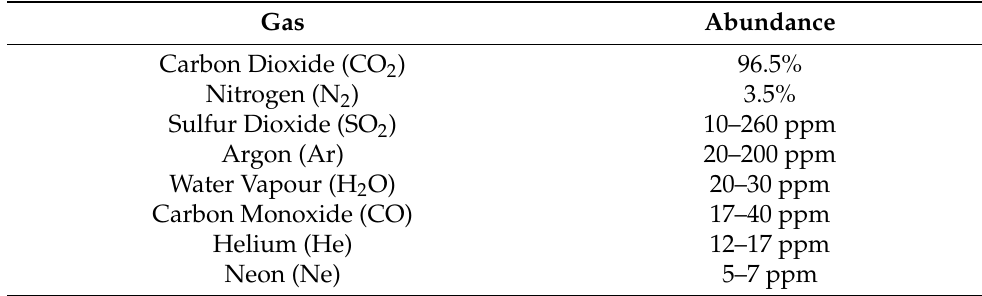
Table 1. Composition of the atmosphere of Venus. The given abundances are obtained from